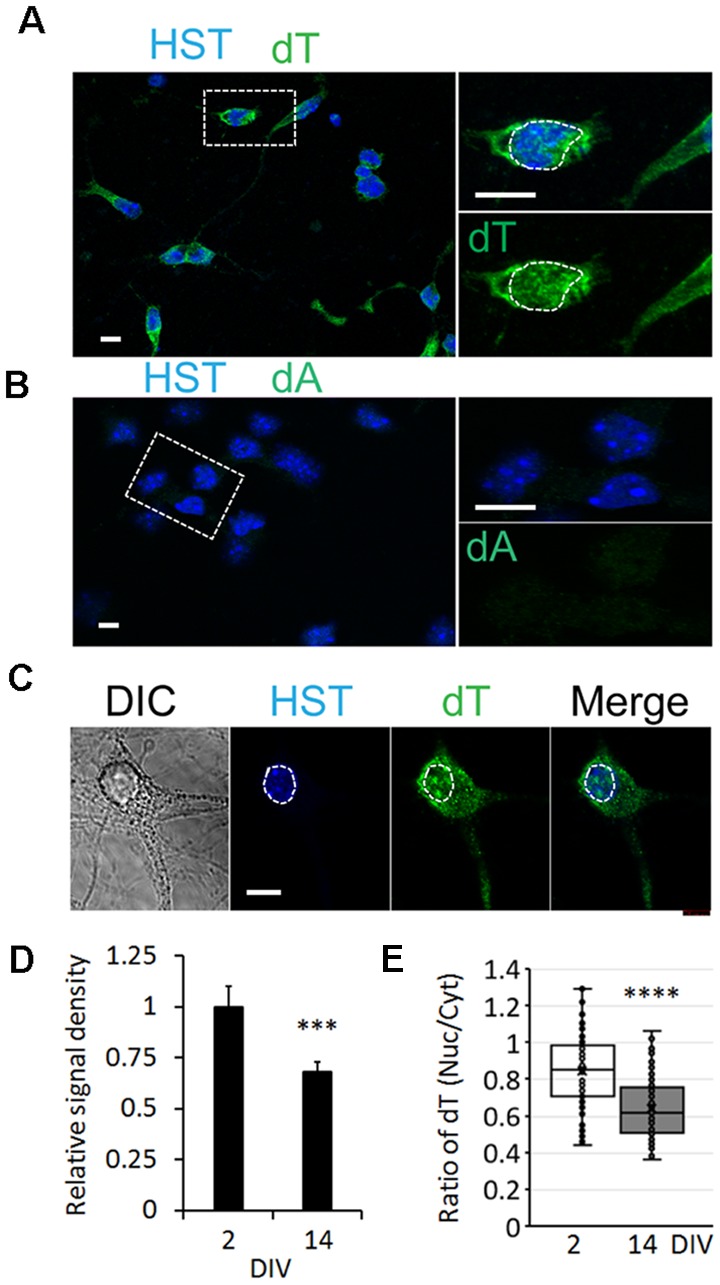
mRNA distribution is influenced by neuronal maturation in primary cortical neurons (PCNs). (A) Confocal micrographs of mouse PCNs at 2 days in vitro (DIV) with fluorescence in situ hybridization (FISH) analysis. The highlighted area with dotted rectangle is also shown in a large magnification on the right. Hoechst 33342 (HST)-stained nuclei. Scale bar: 10 μm. (B) Oligo-dA probes were used as negative control for FISH assay in mouse PCNs at 2 DIV. The highlighted area with dotted rectangle is also shown in a large magnification on the right. Scale bar: 10 μm. (C) FISH analysis of mouse PCNs at 14 DIV. The nucleus is highlighted in a circular dotted line. DIC, differential interference contrast. Scale bar: 10 μm. (D) Relative cellular oligo-dT signal density in PCNs at 2 and 14 DIV. The value of 2 DIV was set as 1. ***p < 0.001. n(neurons) = 86 for 2 DIV and n = 78 for 14 DIV from triplicates. (E) Quantification of oligo-dT signal distribution in PCNs at 2 and 14 DIV. ****p < 0.0001. n(neurons) = 91 for 2 DIV and n = 87 for 14 DIV from triplicates.